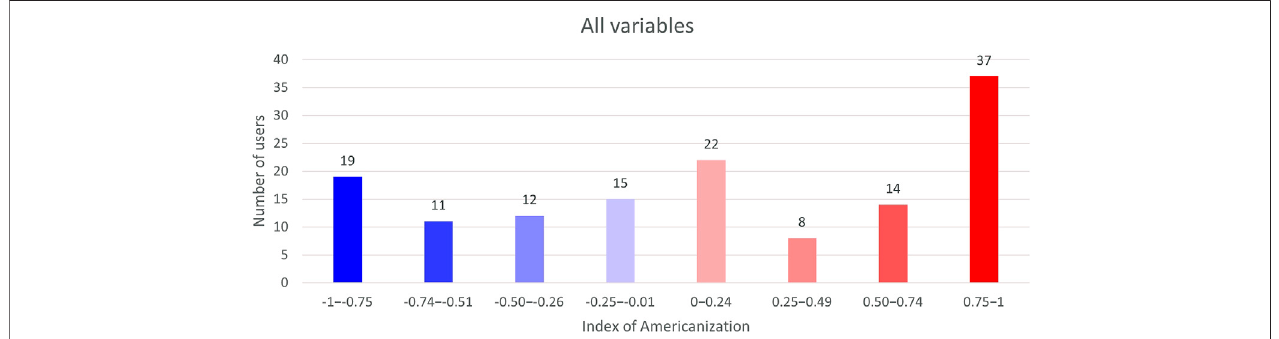
FIGURE 1 | All users ’ indexes of Americanization involving all variables (138 users).